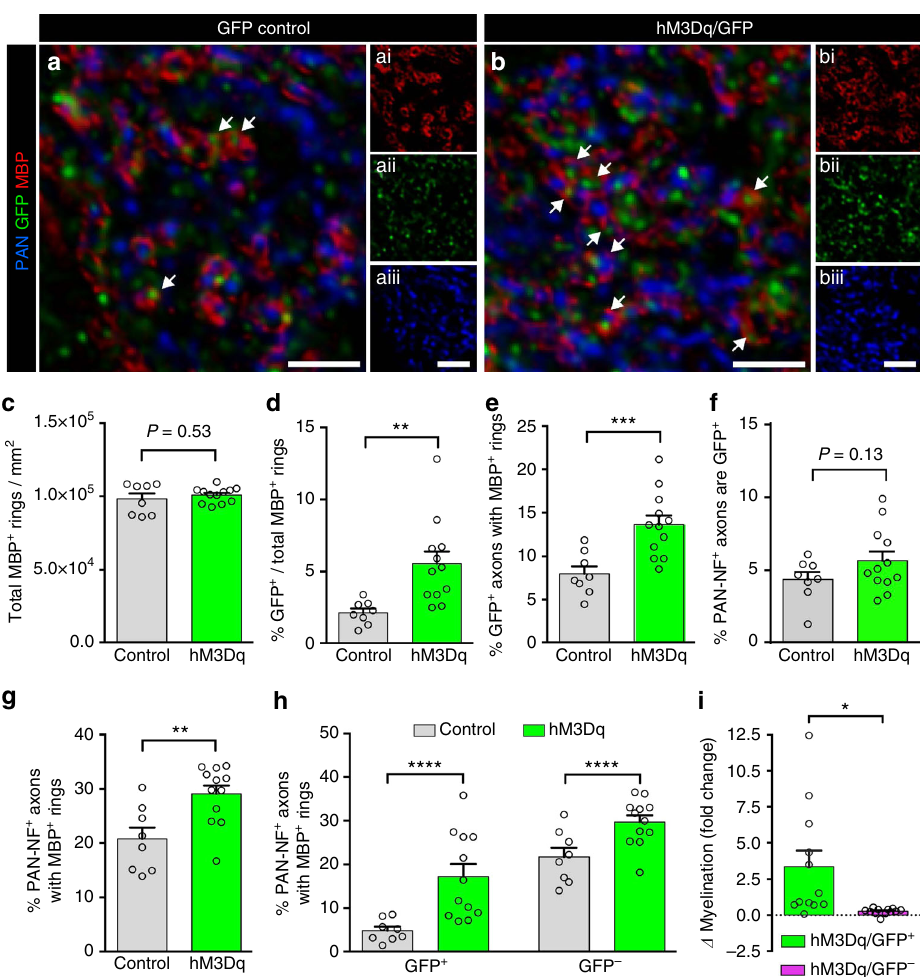
Fig. 4 Activity stimulation results in increased myelination in an axon-selective manner. a , b Representative examples of GFP control ( a ) or hM3Dq/GFP ( b ) mouse callosal axons labeled with PAN-NF (blue), GFP (green), and MBP (red), with white arrows indicating myelinated GFP + axons. c , d Although the total number of MBP + rings in the corpus callosum was similar ( c ), the proportion of myelin rings with GFP + axons was signi fi cantly higher in the hM3Dq- expressing mice compared to controls ( d ). e The percentage of GFP + axons that colocalized with MBP + rings was signi fi cantly higher in hM3Dq/GFP mice compared to GFP controls. f An equivalent percentage of PAN-NF + axons co-expressed GFP in the hM3Dq/GFP and GFP control groups. g The percentage of PAN-NF + axons that colocalized with MBP + rings was higher in hM3Dq/GFP mice compared to GFP controls. h The percentage of GFP + and GFP – PAN- NF + axons that were colocalized with MBP + rings in each group. i The overall change in myelination in hM3Dq/GFP mice was much more pronounced in GFP + axons compared to GFP – axons (values computed as fold change from mean density of GFP +/ − PAN-NF + MBP + axons in GFP control mice). Welch ’ s corrected unpaired two-tailed t -test: **** P < 0.0001, *** P < 0.001, ** P < 0.01, * P < 0.05; n = 8 Control mice (GFP only), n = 12 hM3Dq/GFP mice, ± s.e.m. Scale bars = 2 µ m ( a , b